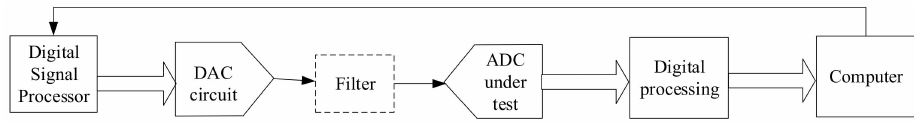
Figure 1. Block diagram of the ADC test scheme.